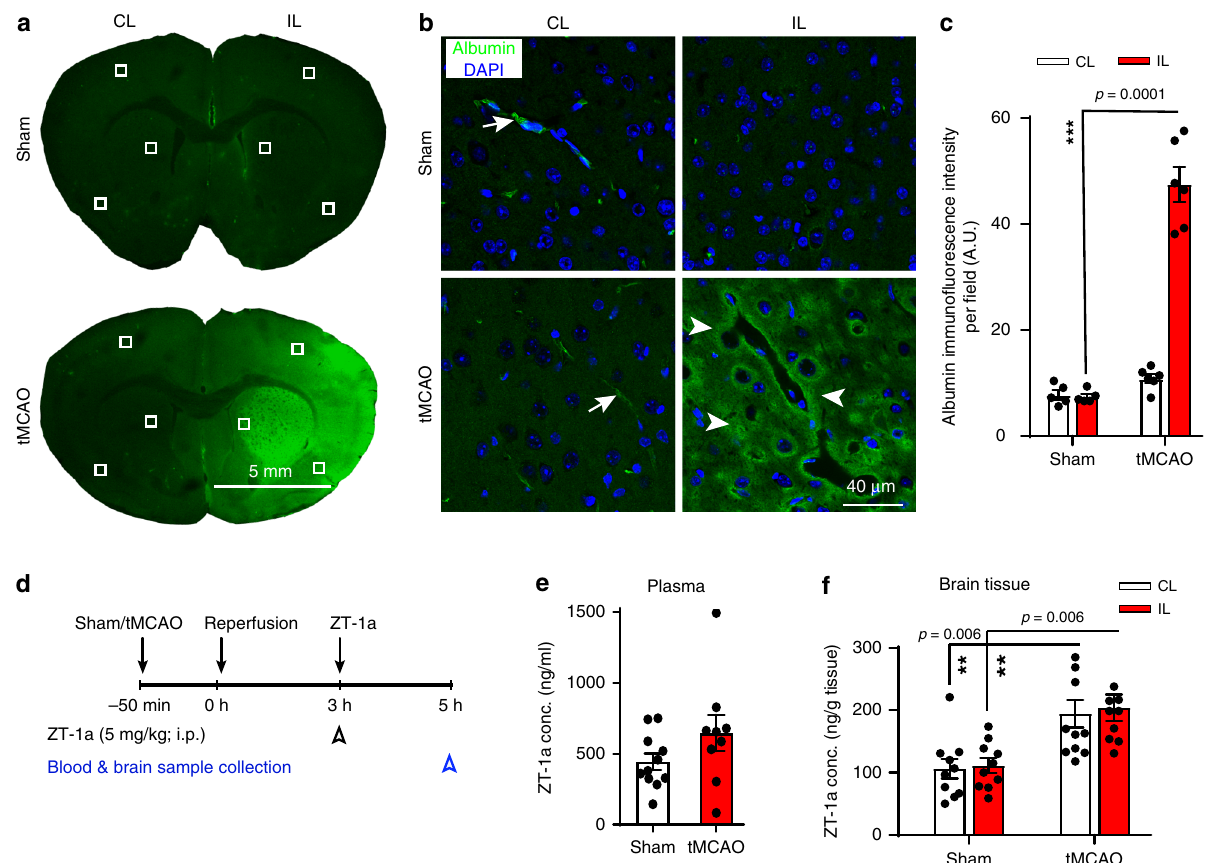
Fig. 6 Ischemic stroke facilitates ZT-1a entrance into the brain. a Anti-serum-albumin-labeled brain sections at 24 h after sham or tMCAO surgery illustrate image collection in the perilesion and contralateral (CL) control areas (white boxes). Note that tMCAO-subjected mice exhibited increased serum-albumin immuno fl uorescence intensity in the ipsilateral (IL) hemisphere compared with that of sham mice. b Higher-magni fi cation (×40) images of serum-albumin immuno fl uorescence. The arrow shows albumin in vessel lumen. The arrowhead shows albumin that has diffused into ischemic brain parenchyma. c Quantitative analysis of albumin immuno fl uorescence intensity as shown in b . Data are mean ± SEM, n = 5 per group (male); *** p < 0.0001, one-way ANOVA. d Experimental design for bioavailability assay of ZT-1a in mouse plasma and brain. ZT-1a was administered at 3 h post reperfusion or post sham surgery. Blood and brain samples were collected at 2 h post injection. e Plasma ZT-1a concentrations were indistinguishable in sham-operated and tMCAO-subjected male mice ( p = 0.29; n = 11 (sham) and 9 (tMCAO)). f Increased ZT-1a concentration was detected in contralateral (CL) and ipsilateral (IL) brain tissues of ischemic versus sham-operated male mice. Data are mean ± SEM, n = 10 (sham) and 11 (tMCAO). ** p < 0.01, one- way (Fig. 8a, b; Supplementary Fig. 11). These results indicate that ZT-1a inhibits the SPAK-dependent upregulation of NKCC1 and KCC3 phosphorylation in ischemic brains.